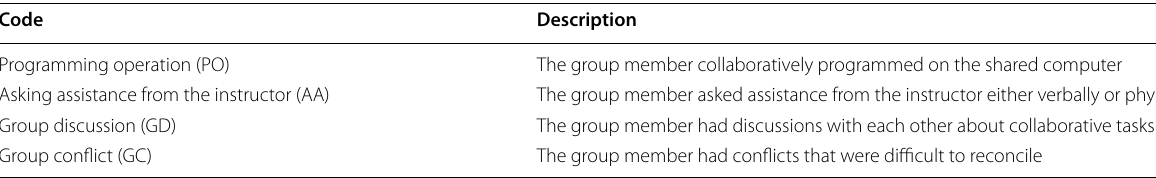
Table 1 The coding framework for analyzing collaborative group states Code